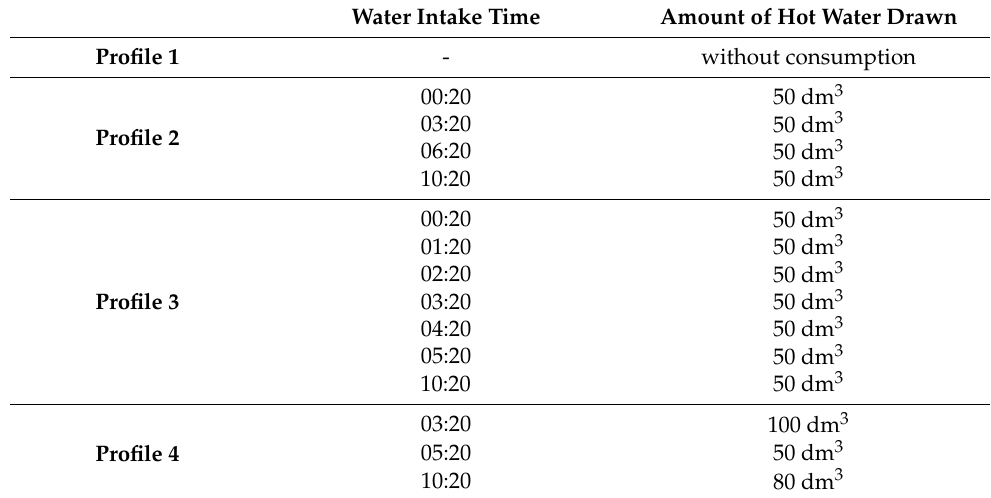
Table 2. Schedule of hot water consumption for partitions. Water Intake Time Amount of Hot Water Drawn Profile 1